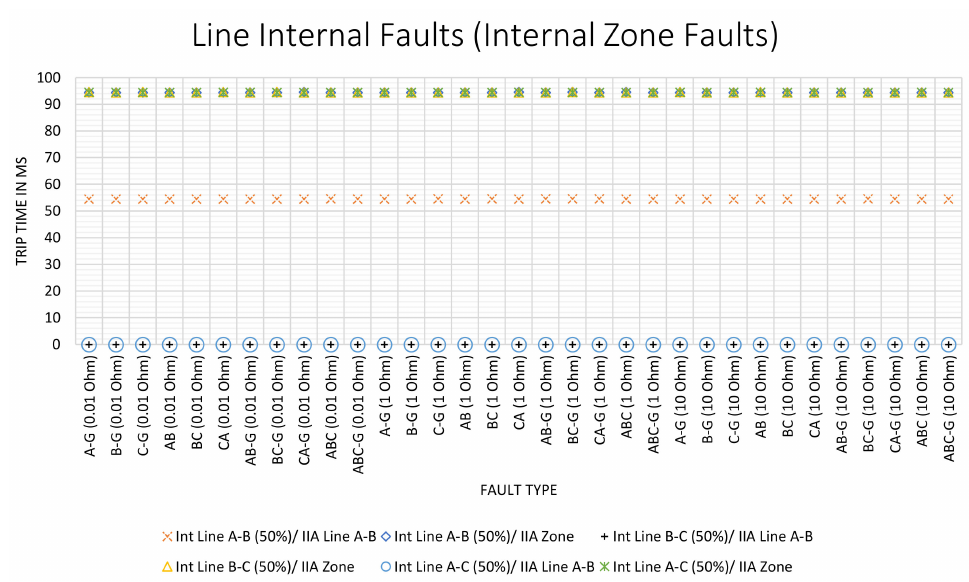
Figure 11. Results for Line Internal Faults tests, Side B without